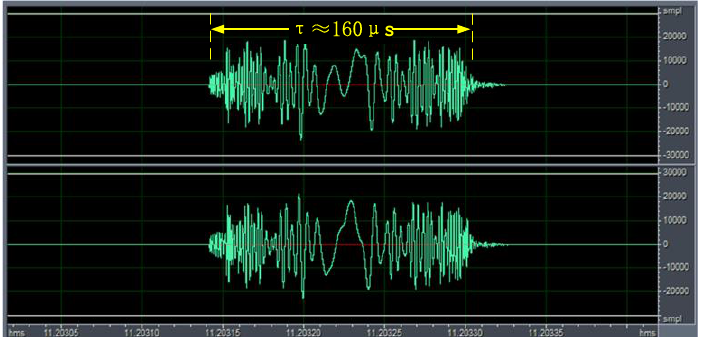
Figure 15. The collected IQ data of the surveillance channel with multiple pulse repetition periods after partial magnification.